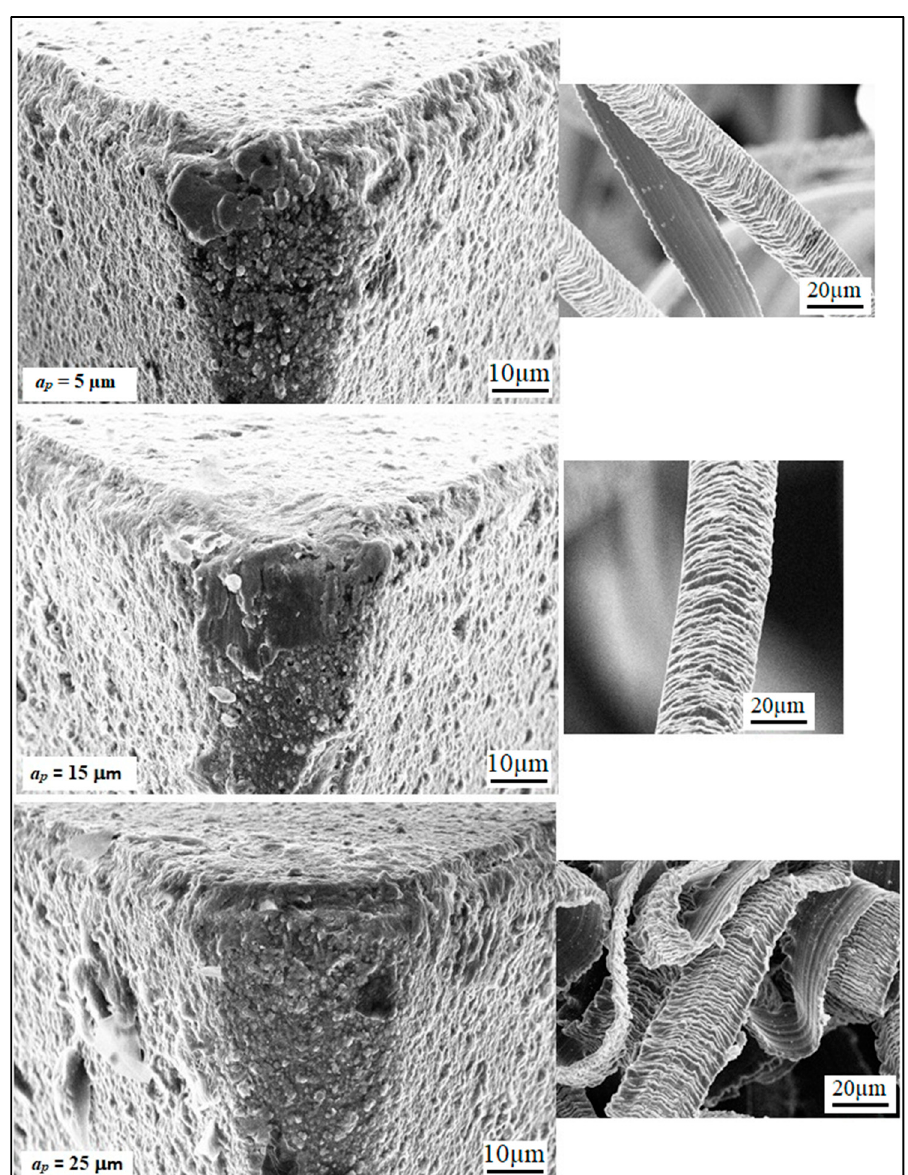
Figure 13. SEM images showing the effect of depth of cut on the tool and chip morphology at V c = 250 m/min and feed rate = 25 µm/rev.